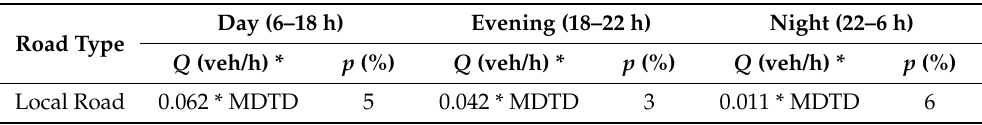
Table 3. Hourly traffic volume of vehicles and percentages of trucks for various time periods used in the model of intersections for Žilina